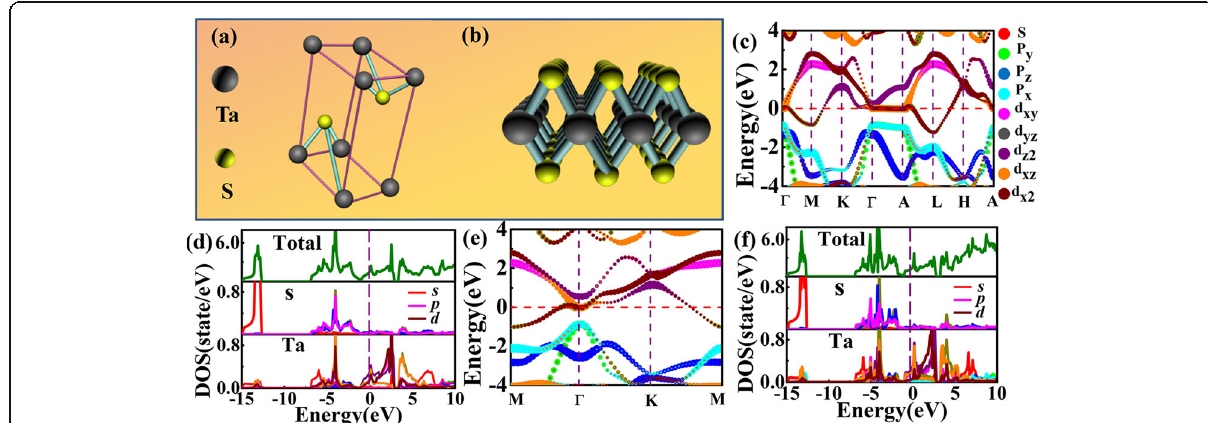
Fig. 5 Structure of TaS 2 , a bulk TaS 2 and b monolayer TaS 2 . c – f Band structure calculations by PBE functional. Partial band structures of bulk and monolayer TaS 2 in c and e , respectively. Partial density of states (PDOS) of bulk and monolayer TaS 2 in d and f ,